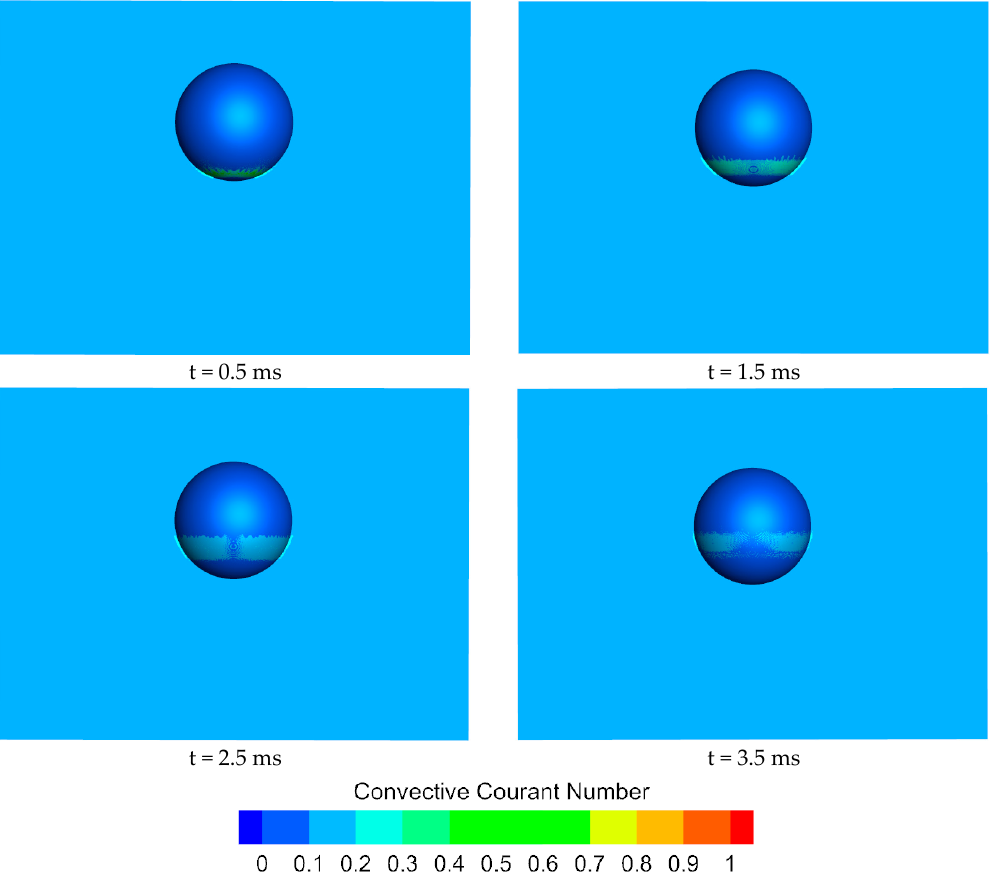
Figure 5. Values of convective Courant number with different time instants.